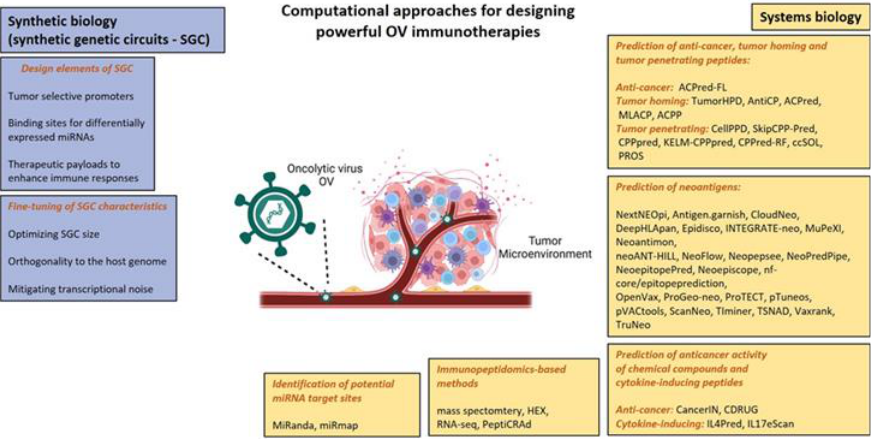
Figure 3. Summary of main computational approaches used in designing effective oncolytic virus immunotherapies, based on [18,37,52,53]. Adapted from “Tumor microenvironment”, by BioRender.com (2022). Retrieved from https://app.biorender.com/biorender-templates (accessed on 17 November 2022).